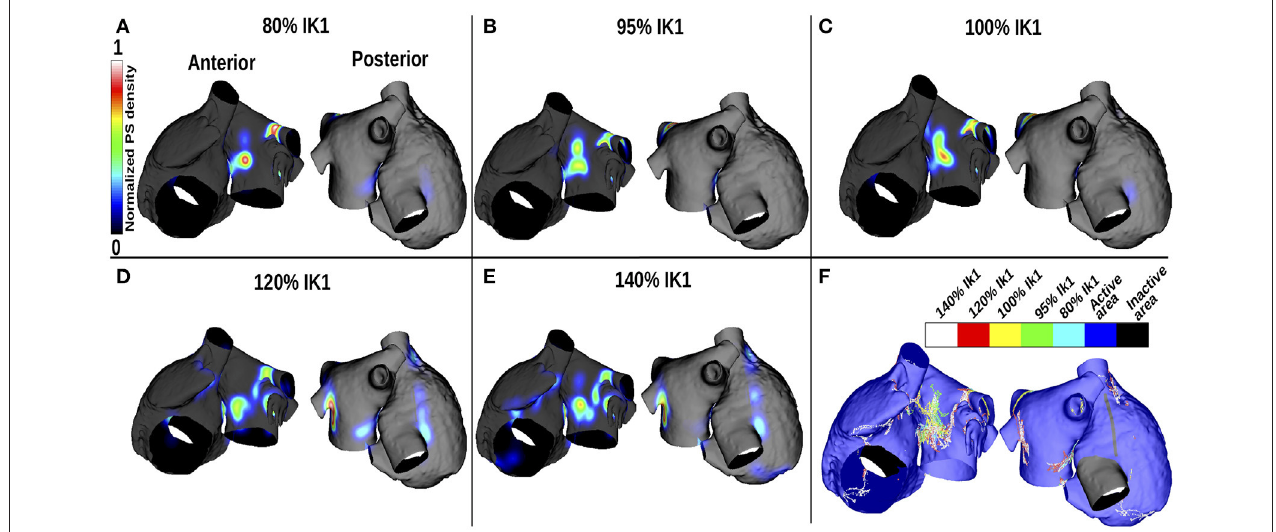
FIGURE 3 | PS density maps change with APD variation for the control case of no atrial fibrosis. Each subfigure shows anteroposterior (left) and posteroanterior (right) views. (A–E) display PS density distributions for 5 I K 1 values. (F) Shows PS positions displayed on the same mesh for the different I K 1 values.